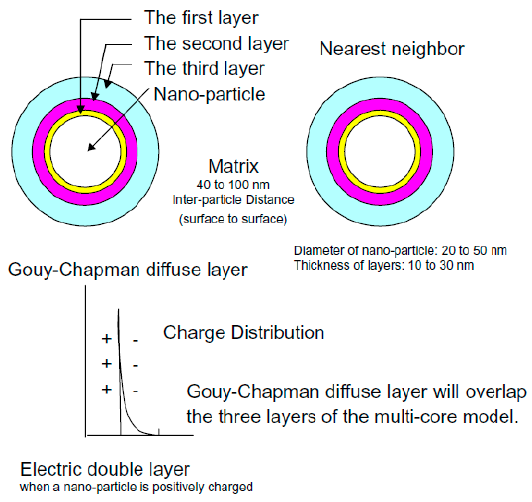
Figure 12. Tanaka’s multi-core model (© 2016 IEEE. Reprinted, with permission, from [76]).